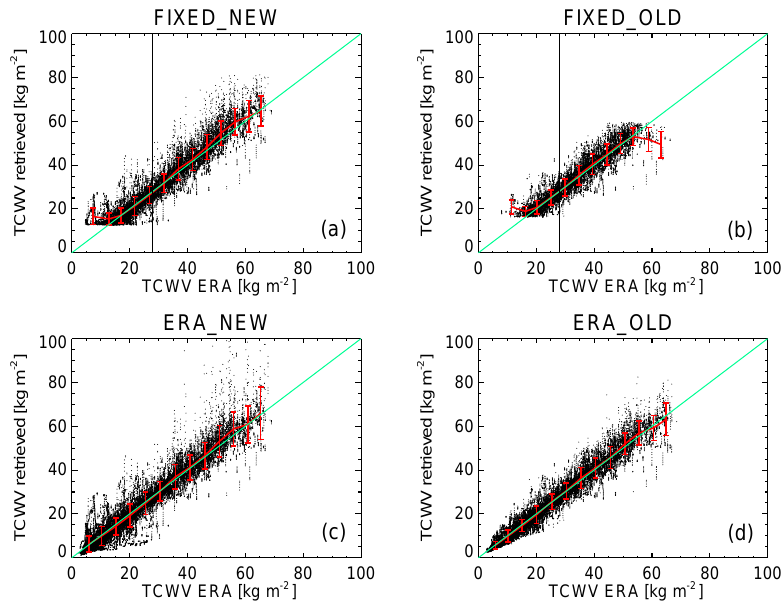
Figure 8. Scatterplots of retrievals obtained with the four different 1D-VAR configurations described in Sect. 2.3.1. In all four panels the retrieved TCWV is plotted against ERA-Interim TCWV. The green line is the 1–1 line. The red error bars show the mean and standard deviation in bins of 5kgm − 2 . The vertical line in the upper two plots shows the TCWV of the fixed climate background used for these plots (mid-latitude summer atmosphere). Total number of retrievals was 35584. Reported values are for valid retrievals with cost function lower than 5. Corresponding statistics are listed in Table